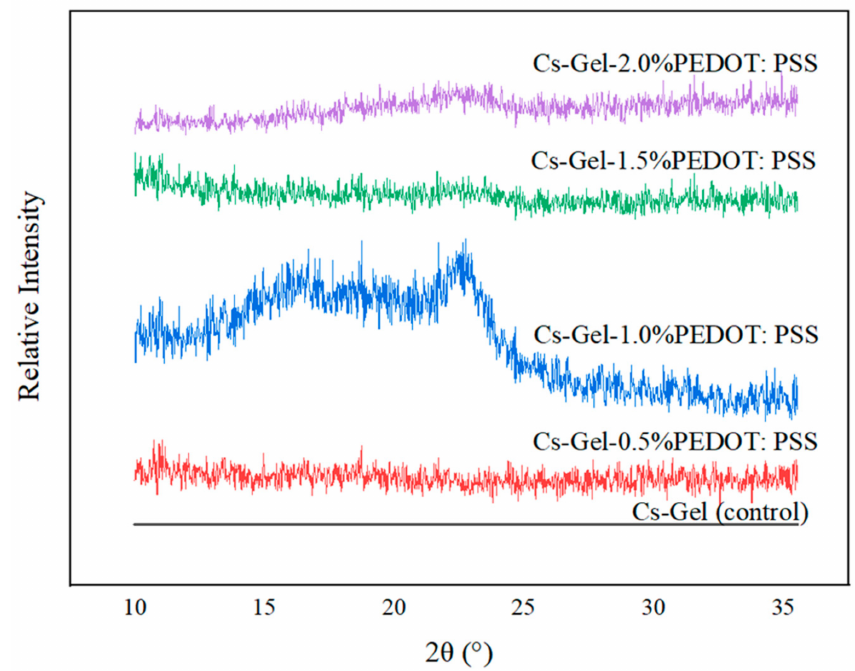
Figure 14. Relative intensity XRD plot of porous